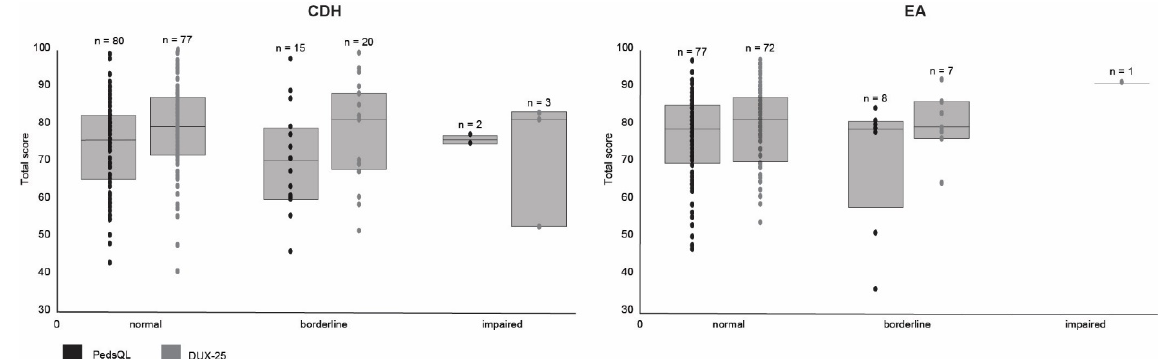
Figure 2. PedsQL and DUX-25 scores for normal, borderline, and impaired cognition. CDH = congenital diaphragmatic hernia, EA = esophageal atresia. Boxes indicate the interquartile range with median.